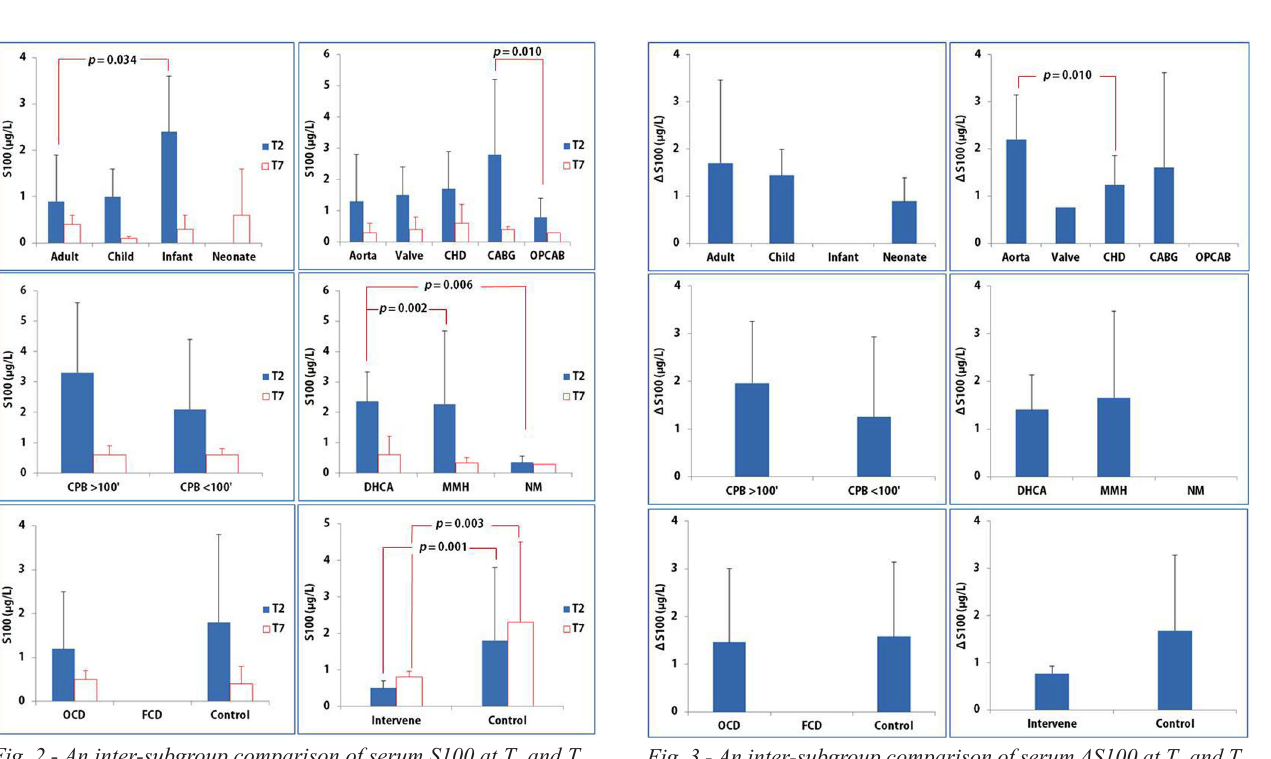
cohorts, respectively ( χ 2 =7.5, P =0.023). ΔS100 increased